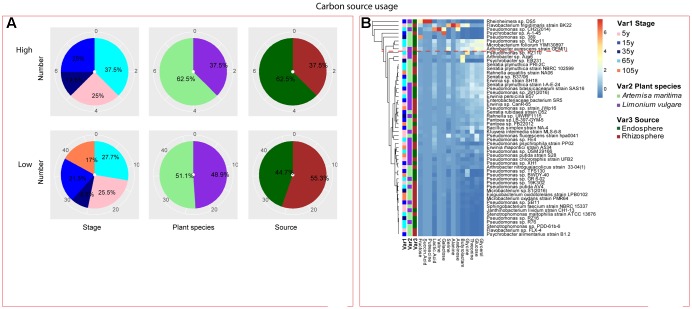
Distribution of metabolic potential of root-associated bacterial strains. (A) Distribution of isolates from different treatments according to high and low growth profiles in metabolic potential. (B) Heatmap profiles for metabolic potential of all isolates. The annotation of treatments - successional stages, plant species and plant compartments and corresponding colors are the same with those in Figure 4. The blue-red gradient bar represents the normalized absorbance values (Z-scores). Only the integer scaled values (0–6) were shown alongside the color bar. The red dashed line separates the high and low bacterial functional profiles, which were determined by the cluster assignment based on the average Euclidean distance among the bacterial strains.